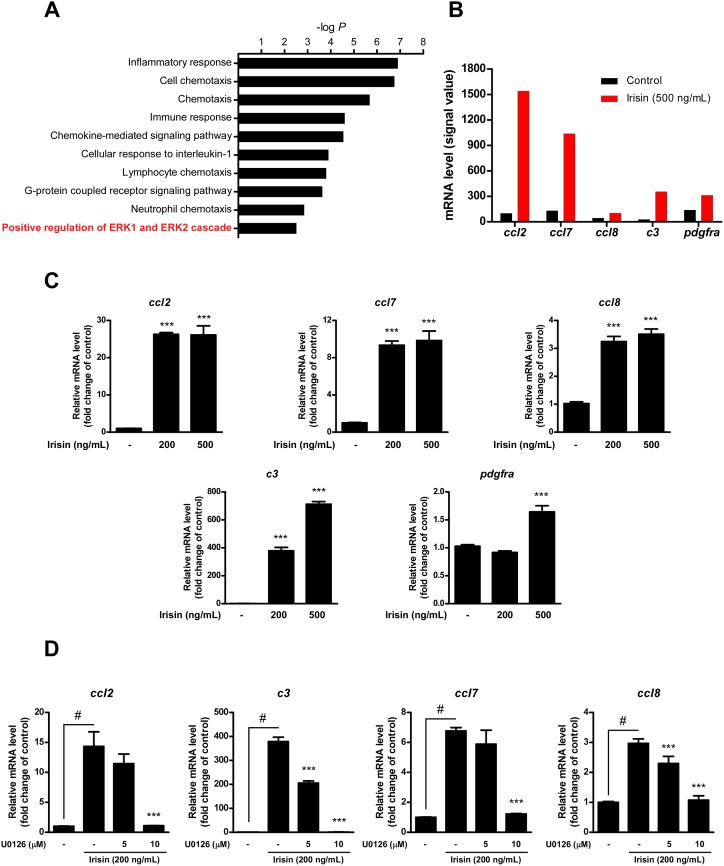
Transcriptomic analysis of irisin-regulated gene expression in C2C12 cells.(A) Gene ontology (GO) analysis of irisin-regulated transcriptome in C2C12 cells. The graph shows–log p values (modified Fisher’s exact P-values) obtained from GO analysis in terms of ‘biological processes’ using microarray data [fold change ≥ 2, pooled samples (n = 3) per group]. (B) mRNA expression levels of enriched genes involved in positive regulation of ERK signaling pathway obtained from microarray data. (C) Validation of expression levels of genes involved in positive regulation of ERK cascade (Ccl2, Ccl7, Ccl8, C3, and Pdgfa). Relative mRNA levels were analyzed by qRT-PCR using SYBR Green dye (n = 3 per group).